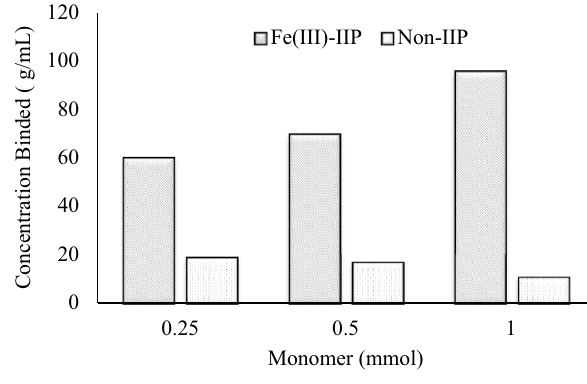
Fig. 4 Optimization of the amount of monomer for the preparation of